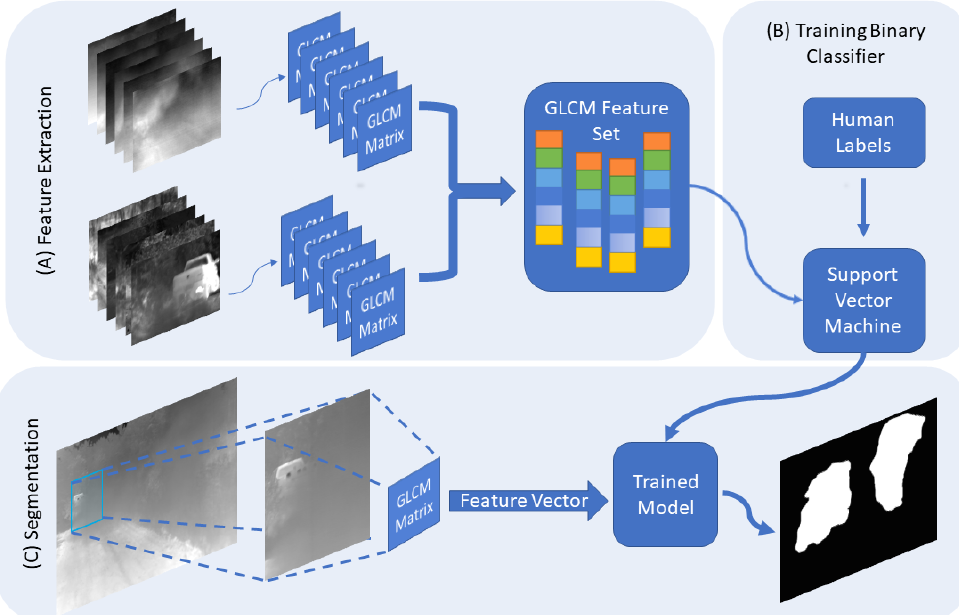
Figure 4. In ( A ), the features are extracted by picking 128 × 128 tiles which are either completely occluded, or clear. Then we extract the GLCM features from tiles with varying sizes. Next, we train the classifier using the feature vectors and the labels from the tiles collected ( B ). To segment the obscuring cloud ( C ), a larger sliding window passes along the image and generates the GLCM features for the window then classifies it. Then a smaller window will only process the tiles that include